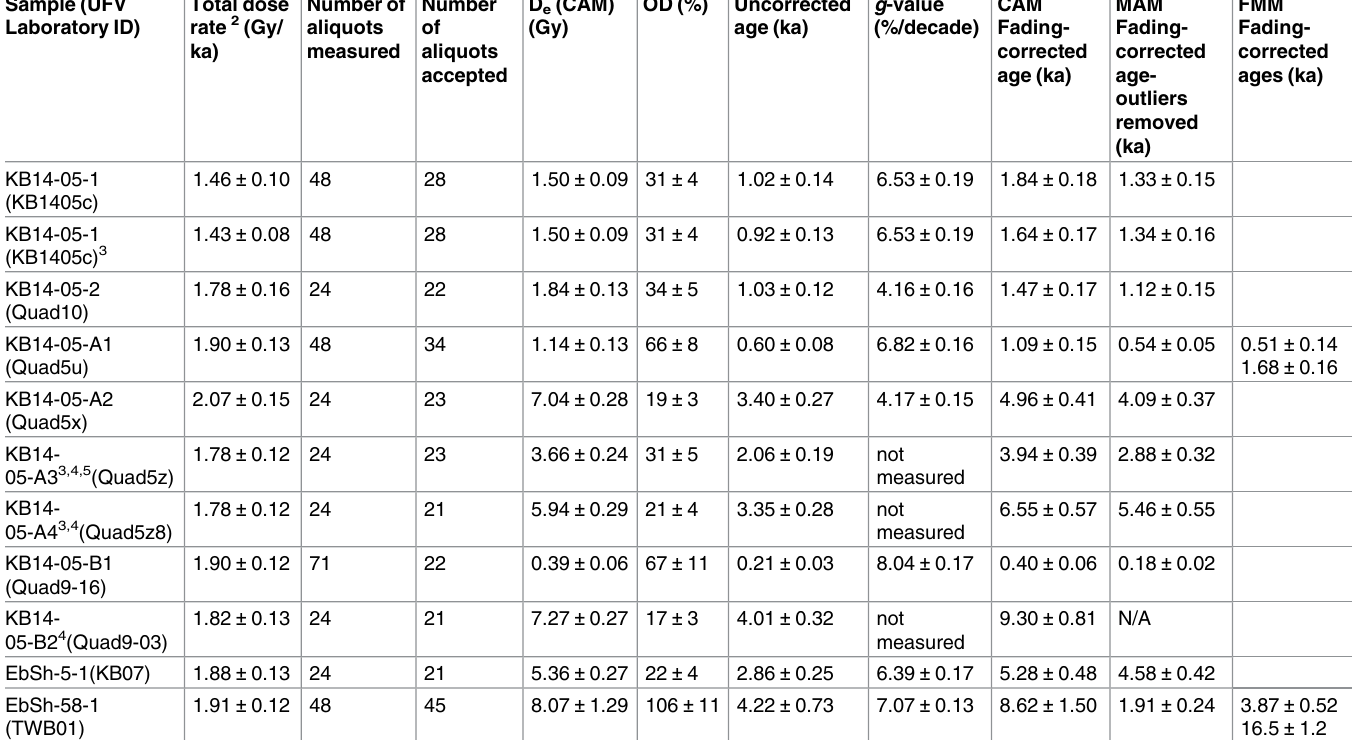
Table 3. Sample D e values, OD values, fading ratesand optical ages 1 . Reportedfadingrates are weightedmeanvaluesfrom 12 multi-grain aliquotsmea- sured from each